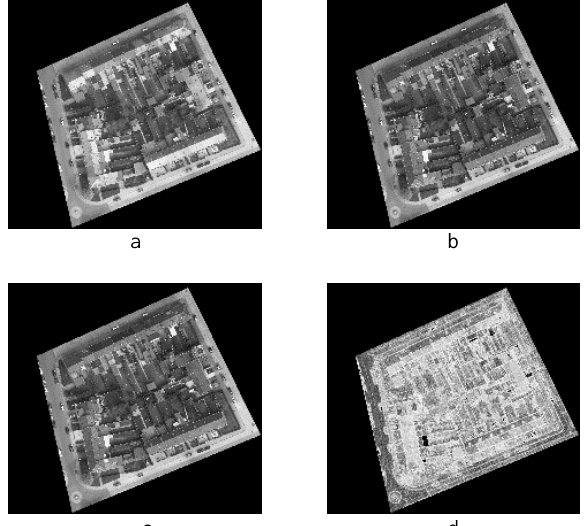
Figure 4. Extracted Features of orthophoto. a. Red channel. b. Green channel. c. Blue channel. d. NDGI.